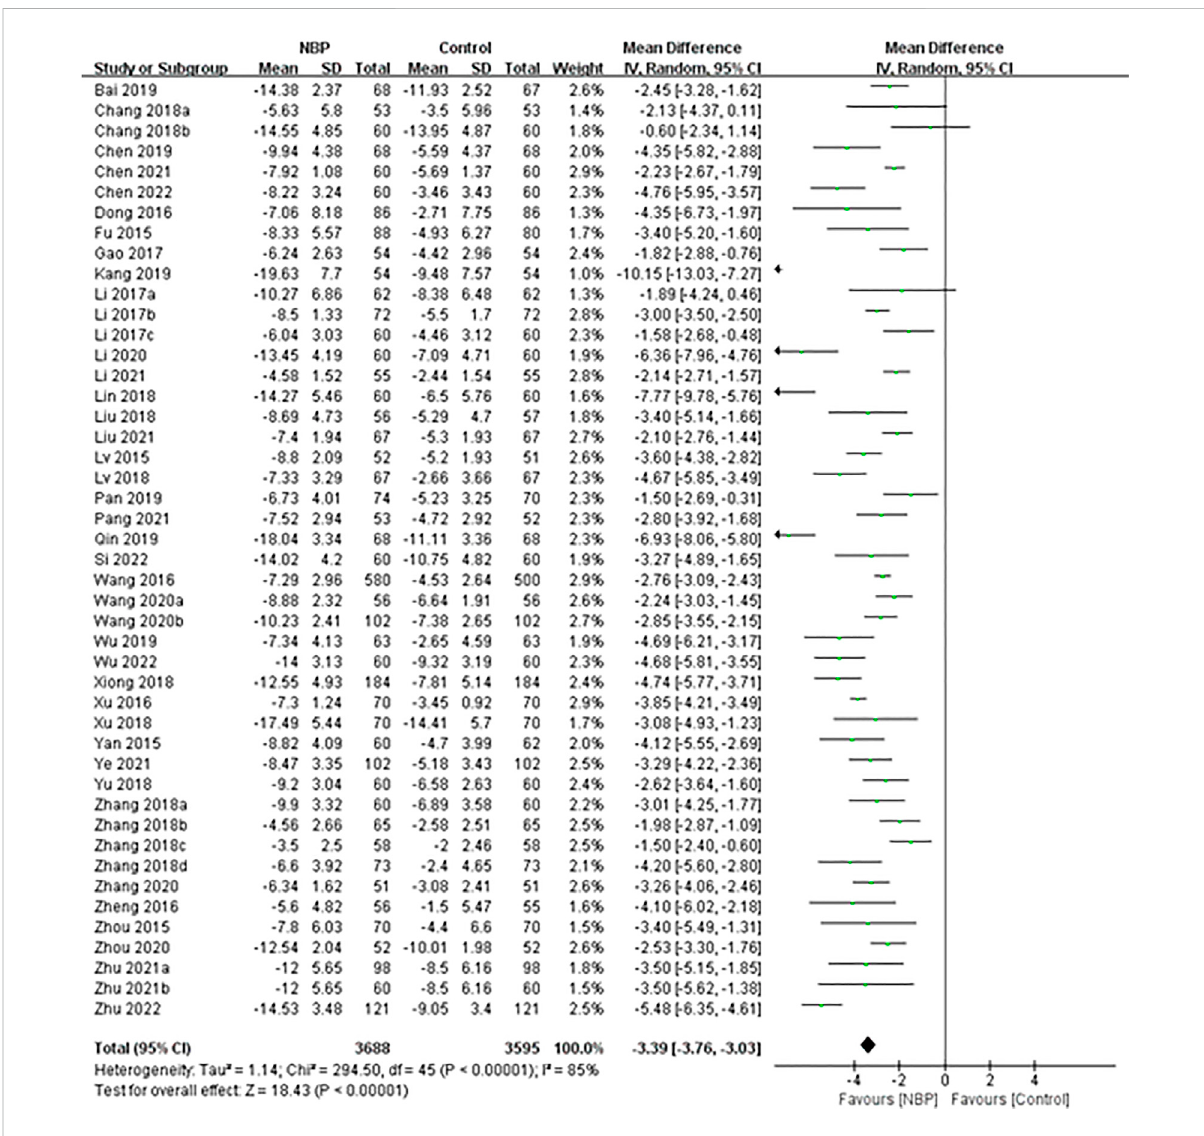
FIGURE 7 Meta-analysis of NIHSS score at the end of treatment or follow-up, as an index of neurological de fi cit.